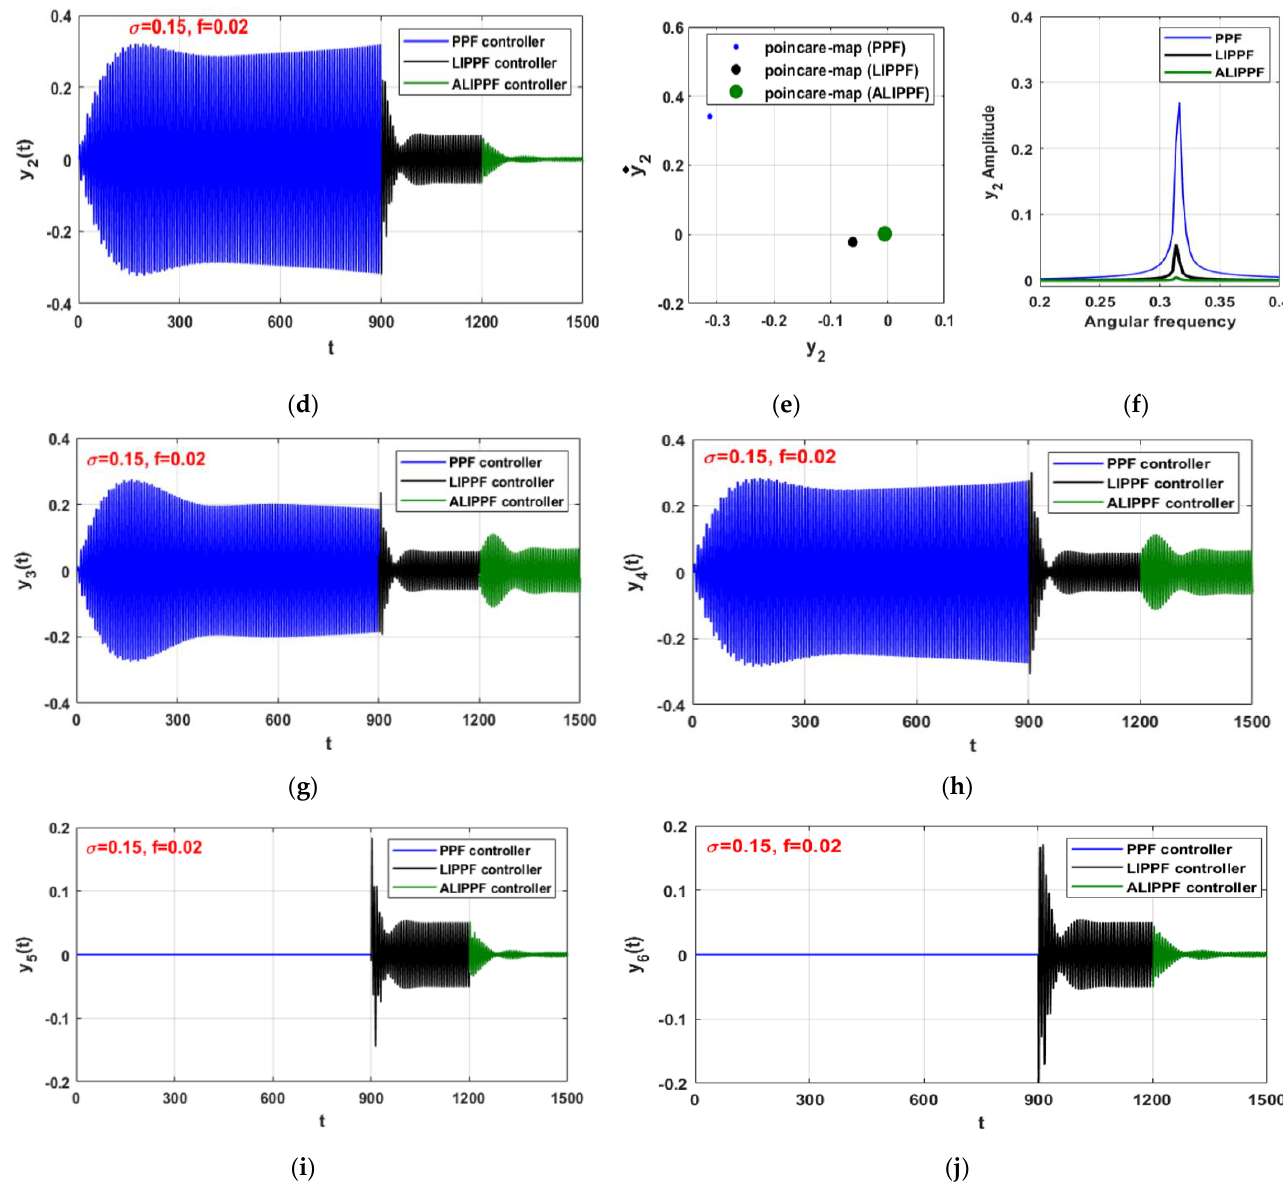
Figure 13. Rotor electro-magnetic suspension time response, Poincare map, and the frequency spectrum with the PPF-controller, LIPPF-controller, and ALIPPF-controller at σ = 0.15 and f = 0.02: ( a , d ) the temporal oscillations of the rotor system in X 1 and X 2 directions, ( b , e ) the corresponding Poincare map of the rotor system, ( c , f ) the corresponding frequency spectrum of the rotor, and ( g – j) the temporal oscillations of the controllers.